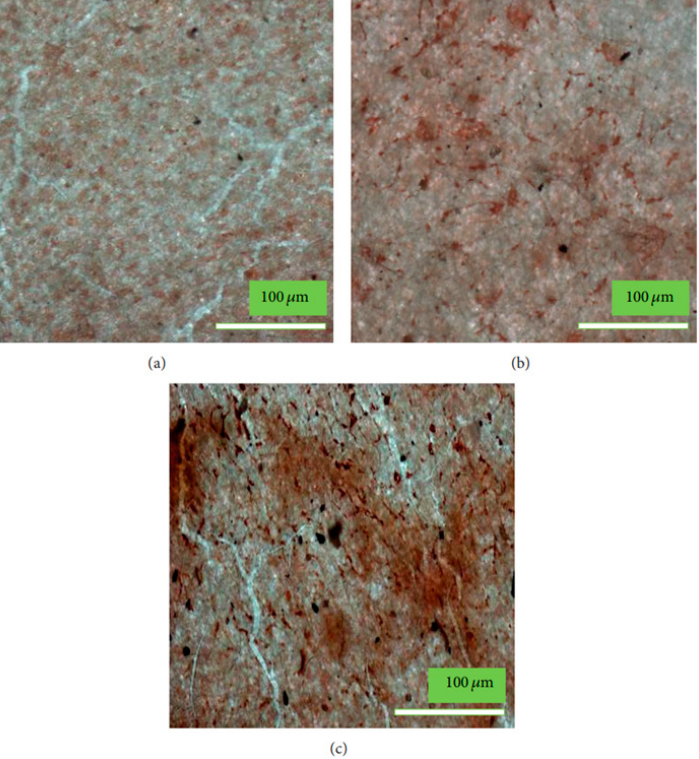
Figure 24. Alizarin Red staining of osteoblasts seeded for 15 days on ( a ) PLGA, ( b ) nHA/PLGA, and ( c ) BMP-g-nHA/PLGA nanofiber scaffolds [21]. ( c ) BMP-g-nHA/PLGA nanofiber scaffolds